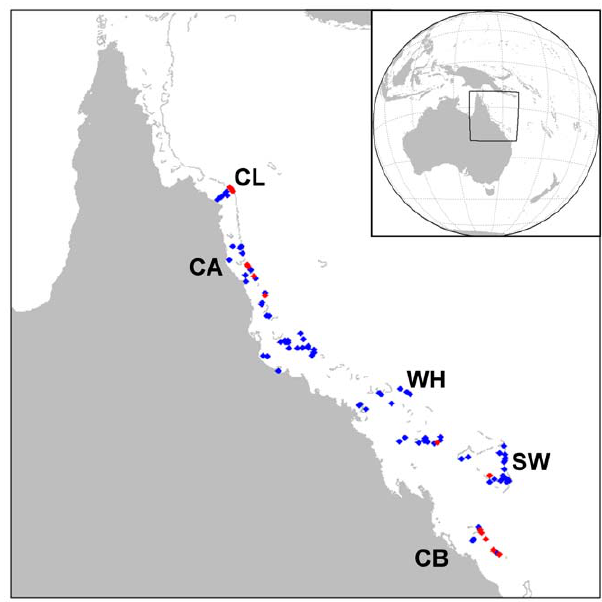
Figure 1. Map of the Great Barrier Reef showing reef locations surveyed for white syndrome abundance. Surveys undertaken as part of the AIMS LTMP and RAP programs. Red symbols indicate locations that experienced a WS outbreak observed during AIMS surveys. Survey sectors indicated for CL=Cooktown-Lizard, CA=Cairns, WH=Whitsunday, SW=Swains and CB=Capricorn-Bunker.